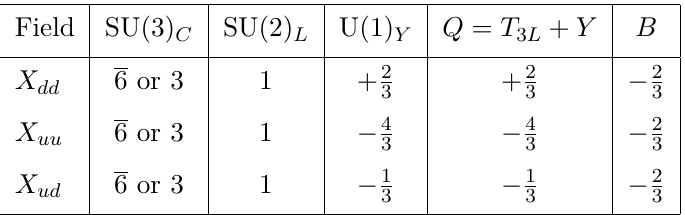
Table 3 . Transformation properties and charges under the SM gauge group of the relevant scalar diquark